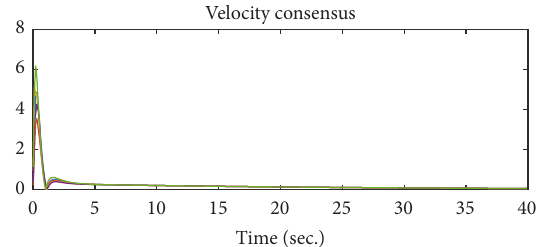
Figure 5: Multiagent velocity trajectory in no obstacle scenario.